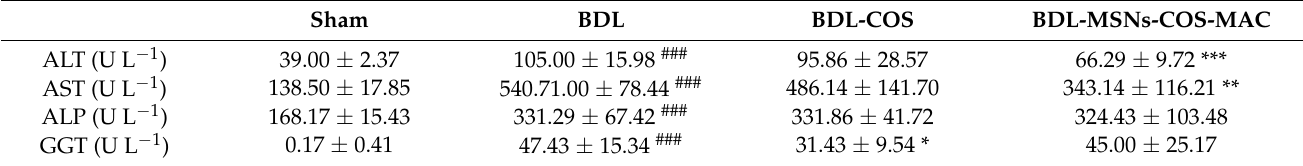
Table 2. Serum biochemical markers of bile duct ligated (BDL)-treated rats, mean ± SD, n = 7. Sham